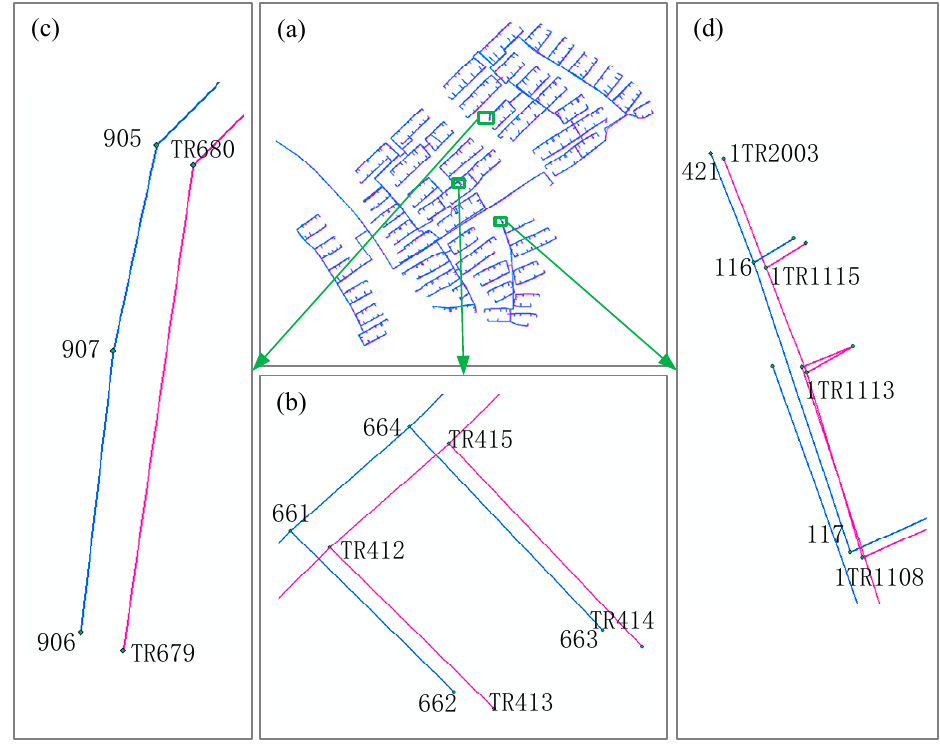
Figure 11. The superposition of the integrated and professional pipeline maps. The blue lines represent integrated pipelines, and the pink lines represent professional pipelines. ( a ) Shows the superposition; ( b ) shows the 1:1 Matching Type; ( c ) shows the n :1 Matching Type; ( d ) shows the n : m Matching Type. Table 2. Example of matching types in the integrated and professional pipelines.